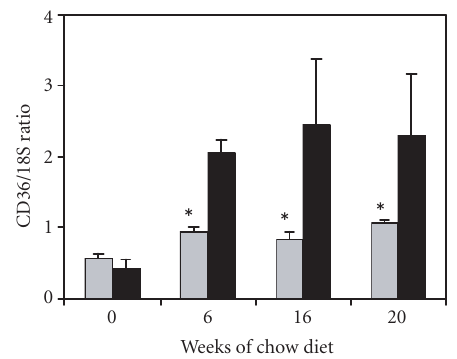
Figure 4. Northern blot analysis of CD36 mRNA levels in the testis.